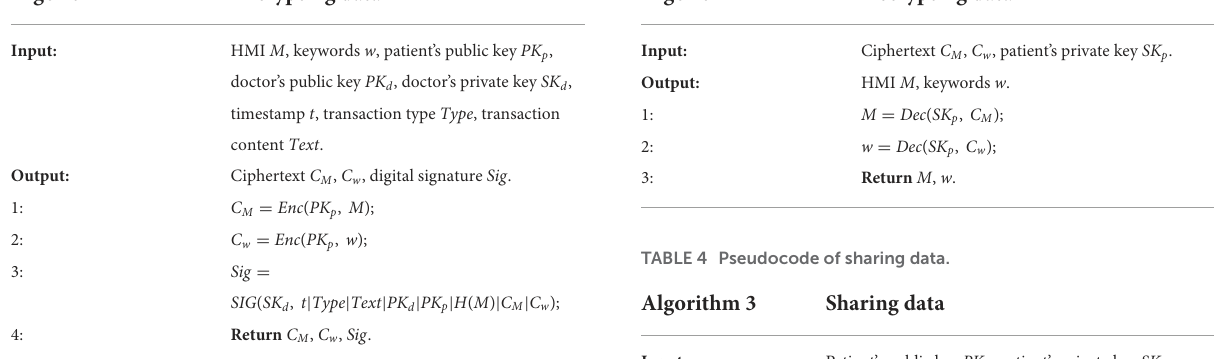
TABLE 2 Pseudocode of encryting data. Algorithm 1